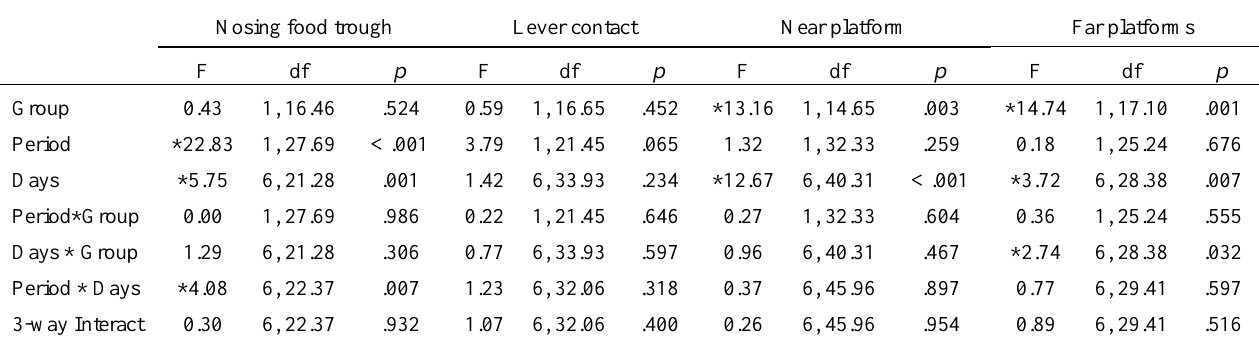
Inferential S tatistics from Experiment 3